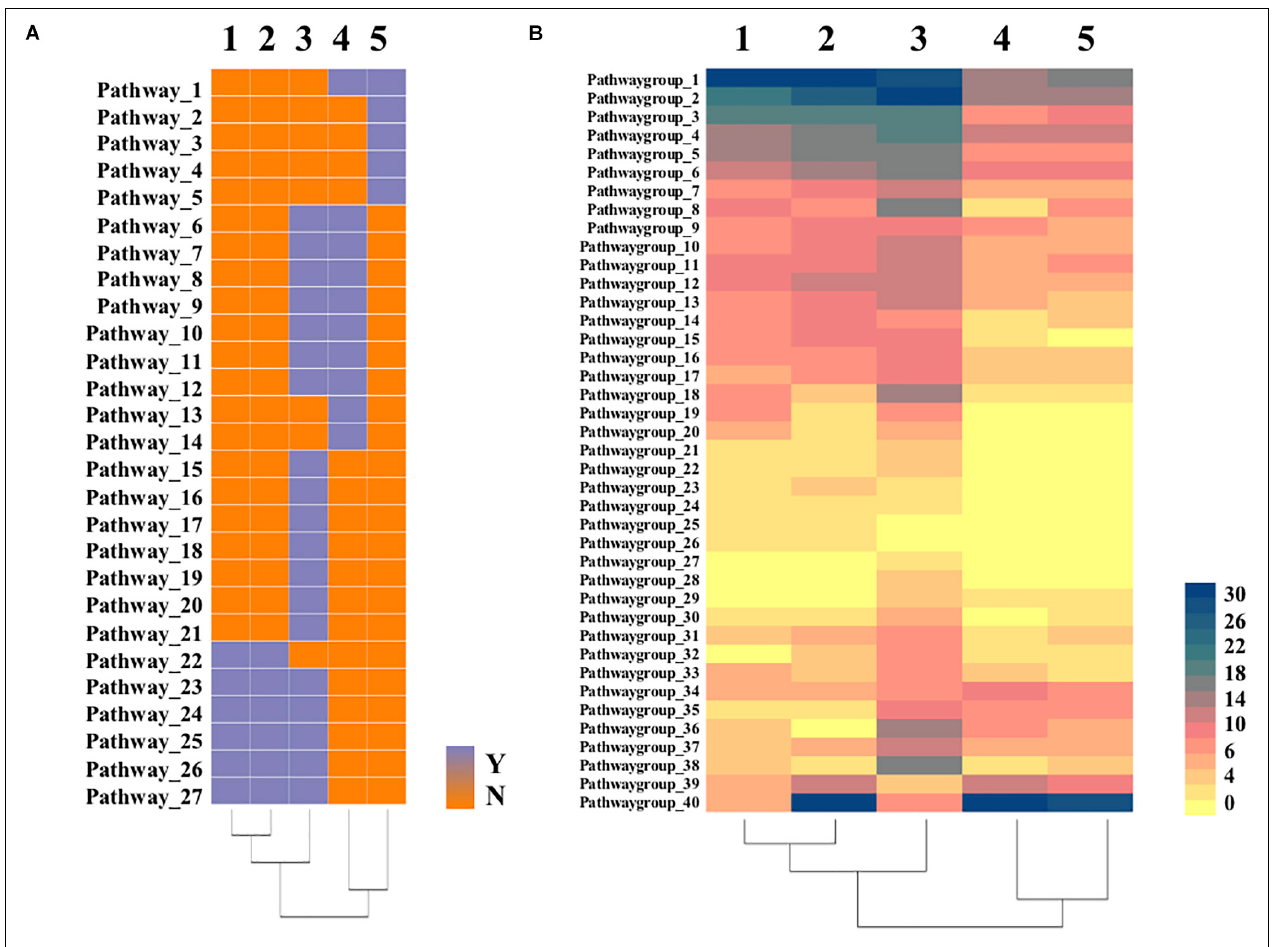
FIGURE 4 | Heatmaps of comparative genomic analysis between strain YN101 T and related strains. (A) heatmap clustered with 27 pathways according to annotation of the RAST and KEGG; (B) heatmap clustered with gene numbers of 40 metabolism groups according to annotation of the RAST and KEGG. 1, Strain YN101 T ; 2, Bradymonas sediminis FA350 T ; 3, Myxococcus xanthus DK1622 T ; 4, Bdellovibrio bacteriovorus HD100 T ; 5, Bdellovibrio exovorus JSS T